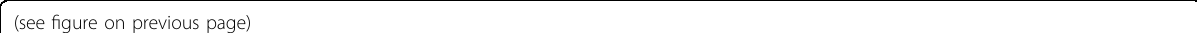
Fig. 5 Neck FPLD2 adipose tissue shows an intermediate brown/white phenotype and absence of BAT activity. Characterization of adipose tissue isolated from the neck district of healthy donors (control neck), subcutaneous tissue from the leg of healthy donors (control subcutaneous), and FPLD2 patients neck (FPLD2 neck) is shown in a – c . a Electron microscopy analysis of control and FPLD2 adipose tissue. Small lipid droplets fusing to a large droplet are indicated by double arrows. Bar, 2 μ m. The mean adipocyte area is reported in the graph. Statistically signi fi cant differences relative to control neck tissue are indicated (*). b Western blot analysis of prelamin A and lamin A/C in control and FPLD2 adipose tissue, and densitometric analysis. Statistically signi fi cant differences between control and FPLD2 tissue samples are indicated (*). c Western blotting analysis of PPAR γ and UCP1 in control and FPLD2 adipose tissue and densitometric analysis. Statistically signi fi cant differences between control and FPLD2 tissue samples are indicated (*). In b and c : actin band is shown as a protein-loading control; molecular weight markers are reported in kDa. Cold- induced fat 18 F-2- fl uoro-2-deoxy-D-glucose ( 18 F-FDG) uptake in the supraclavicular regions, face, neck, and skeletal muscle of FPLD2 patients is shown in d , e . d Representative CT and CT-PET images referring to one out of three examined FPLD2 patients are shown. e Levels of cold-induced glucose uptake ( 18 F-2- fl uoro-2-deoxy-D-glucose ( 18 F-FDG) uptake) in fat depots of the face, neck supraclavicular regions, and trapezius muscle (skeletal muscle) of FPLD2 patients. Data are means ± SD